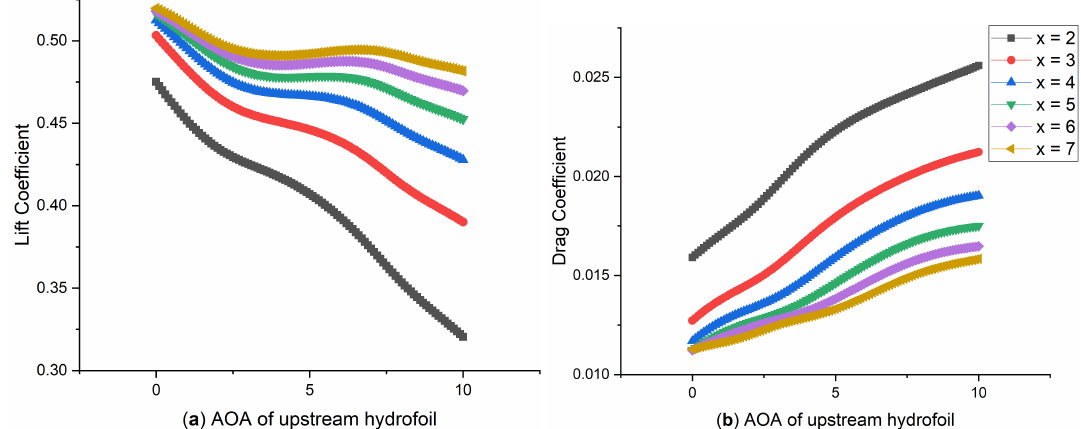
Figure 10. The effect of the AOA of upstream hydrofoil on the downstream hydrofoil’s ( a ) Lift Coefficient ( b ) Drag